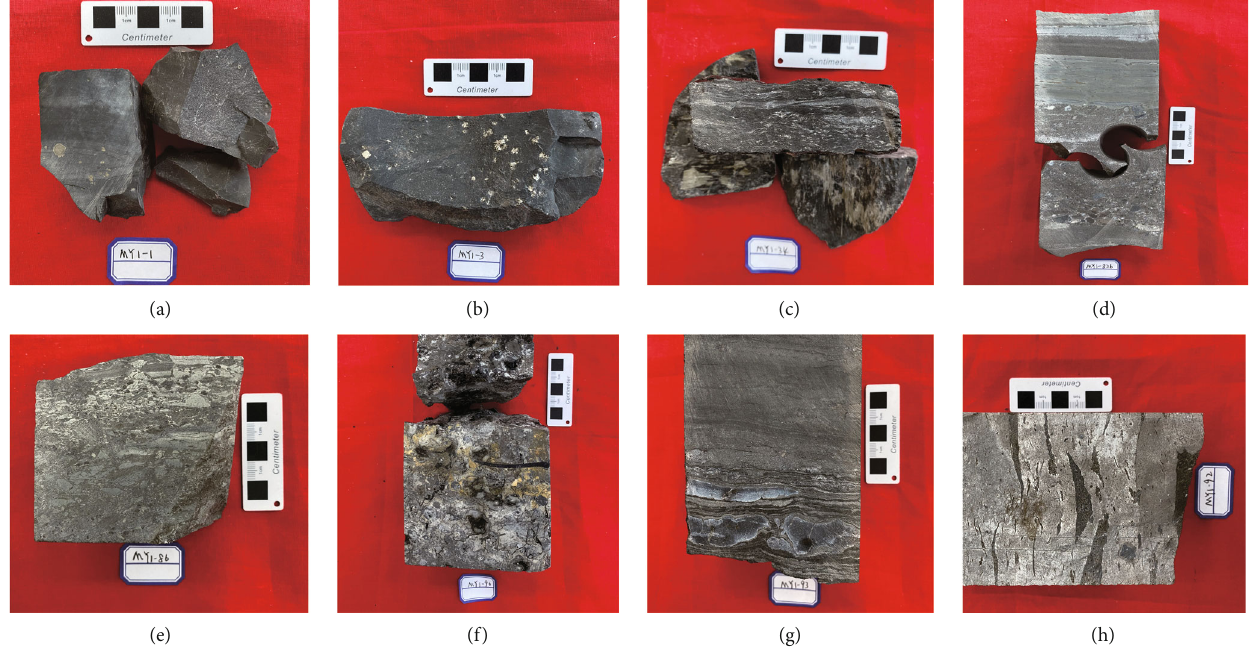
Figure 3: Cores of the Fengcheng Formation in the Mahu Sag. (a) Silty mudstone, P containing pyrite, P limerock, clastic rocks, siltstone, and argillaceous siltstone, P terrigenous clast, P 4917.6m; (h) tu ff , P